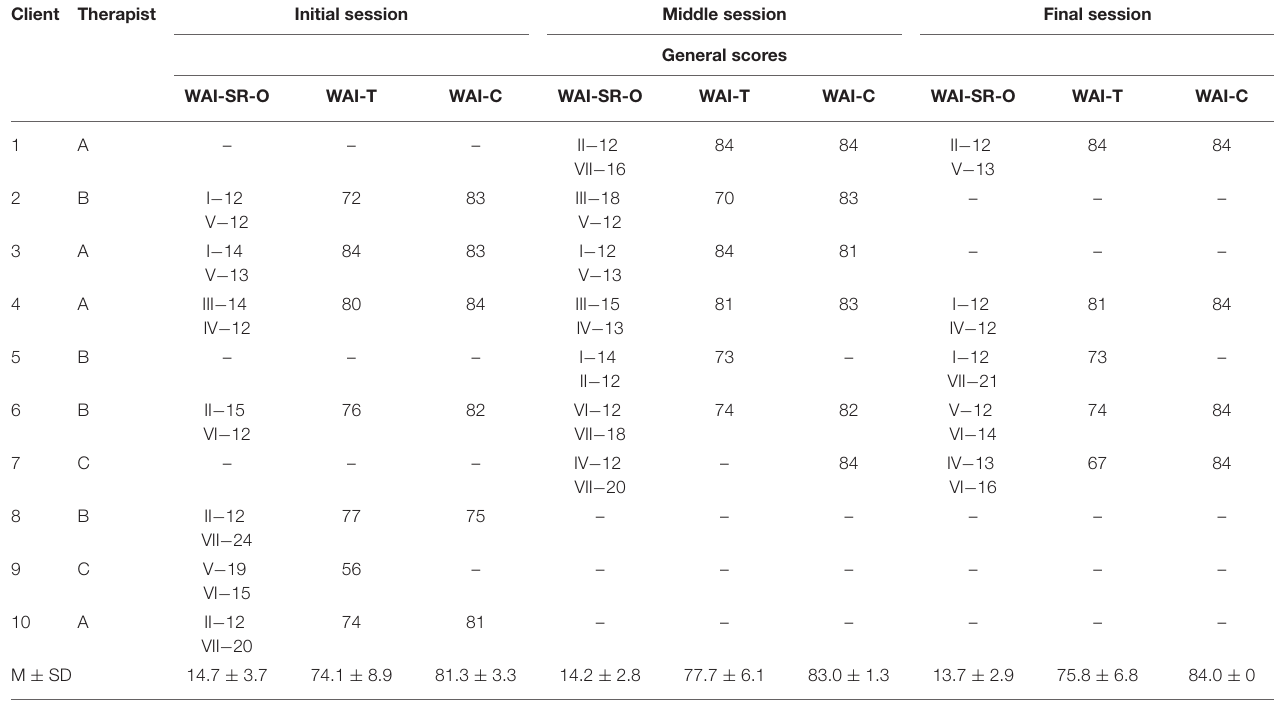
TABLE 1 | Description of clients, therapists, sessions and general scores evaluated by pairs of Working Alliance Inventory-Short Form-Observers (WAI-SR-O), Working Alliance Inventory therapists (WAI-T), and Working Alliance Inventory clients, (WAI-C) and the scores observed of the general scales. Client